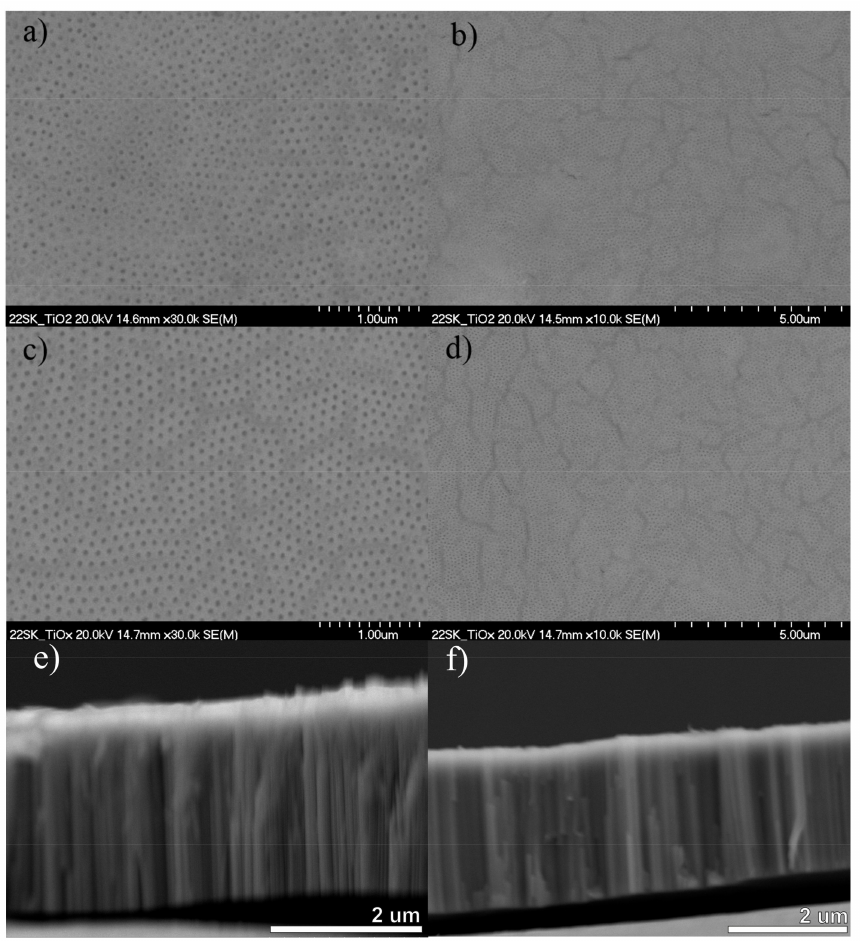
Figure 4. SEM images of TiO 2 nanotubes after ( a , b , e ) anodization and annealing, and ( c , d , f ) electro- chemical reduction at 5 V for 10 min in a 50:1 glycerol–water solution with 0.27% NH 4 F (sample E). The observed waves in the 500–800 nm region might originate from the Fabry–P é rot oscillations. However, Song et al. [45] reported that the appearance of such an effect is connected to the morphology of the tube walls. It was shown that in the case of single or double-layer smooth tube walls, only a broad reflection peak is present. To achieve Fabry– P é rot fingers, rippled tubes have to be formed by adding more water into the ethylene glycol-based electrolyte. Anodic TiO 2 synthesized in this paper had smooth walls and a total thickness of ~2.5 ± 0.15 µ m (see Figure 4). Nevertheless, as this effect is observed for the nonreduced material and above 800 nm it is a physical